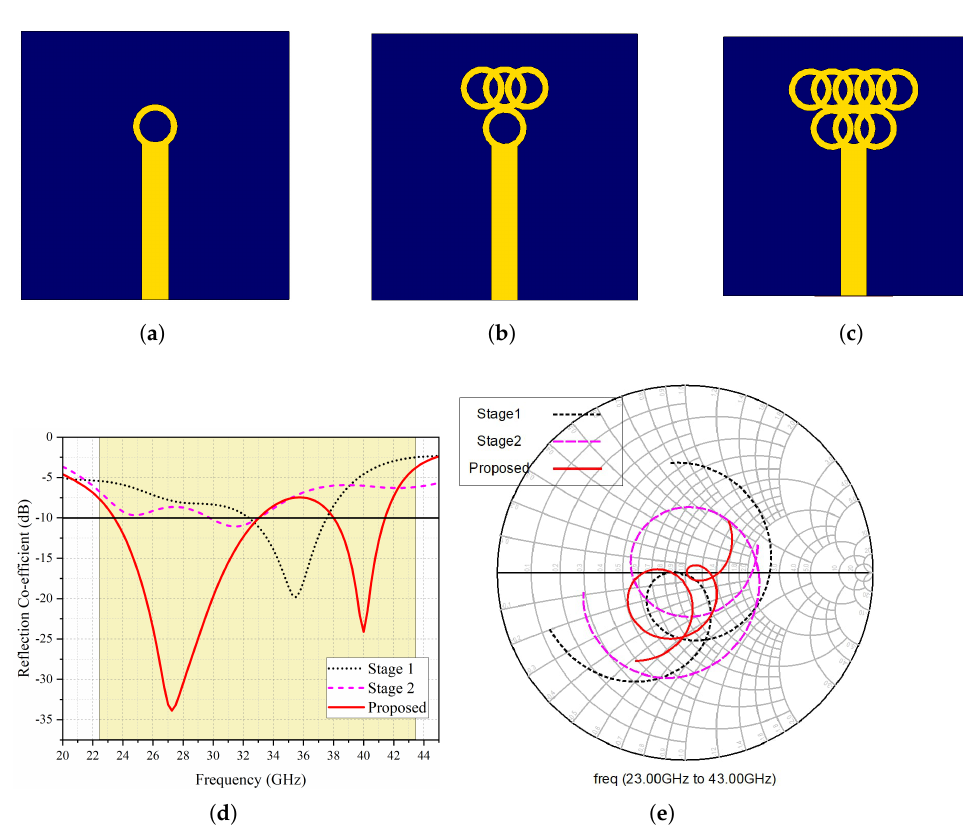
Figure 2. Design evolution ( a ) stage 1 ( b ) stage 2 ( c ) proposed ( d ) reflection co-efficient ( e ) Smith